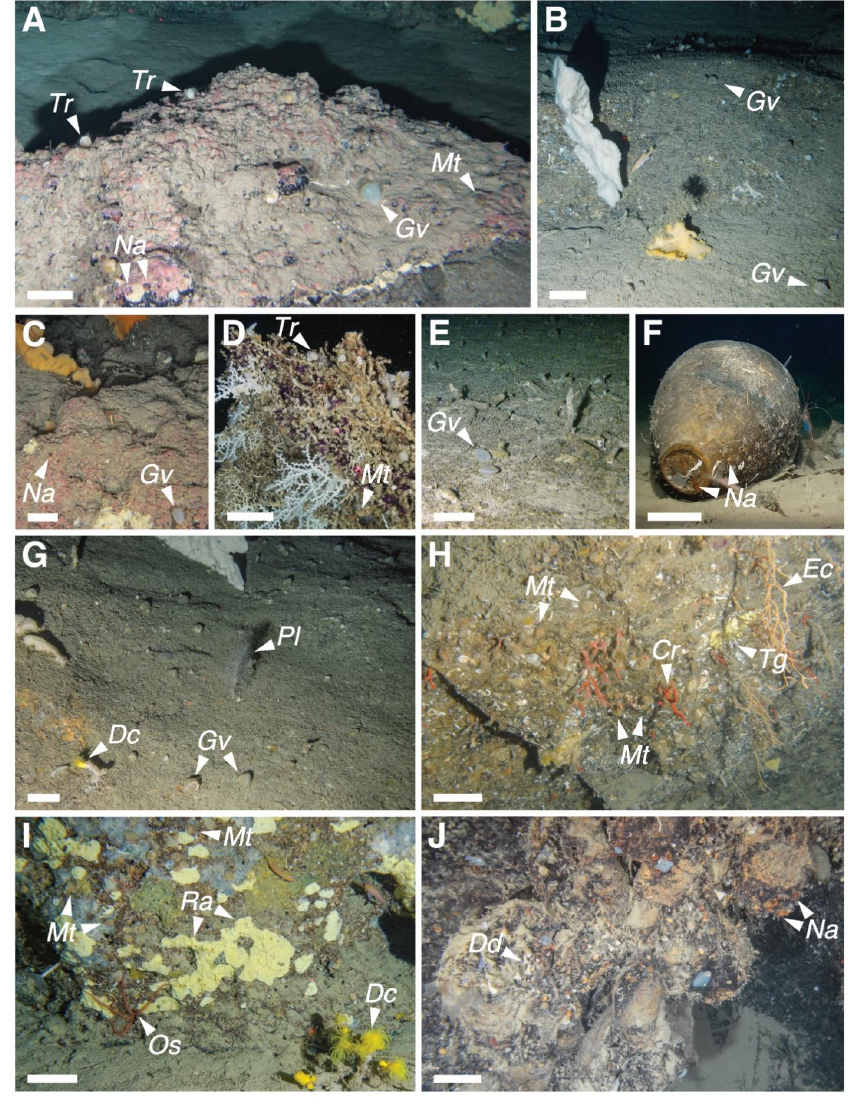
Figure 3. Ecology of the target species. ( A ) The four species together on a CCA-encrusted rock in the Pontine Archipelago (central Tyrrhenian Sea, 160 m); ( B ) specimens of G. vitreus (Gv) on a rocky boulder and on the surrounding soft bottom. Well visible the massive sponges Pachastrella monilifera and Poecillastra compressa (Vedove Shoal, western Ligurian Sea, 195 m); ( C ) sloping rock with CCA hosting G. vitreus and N. anomala (Na), together with P. compressa (Pontine Archipelago, central Tyrrhenian Sea, 160 m); ( D ) T. retusa (Tr) and M. truncata (Mt) settled on a Madrepora oculata bioconstruction, very close to the living portions of the reef (Tavolara Canyon, North-eastern Sardinia, 185 m); ( E ) individuals of G. vitreus on an horizonthal plain with skeletons of Dendrophyllia cornigera (Dc) on Vercelli seamount (central Tyrrhenian Sea, 160 m); ( F ) N. anomala on the vertical sides of an ancient terracotta amphora. On the right, an individual of Plesionika narval walking on the manufact (North Tyrrhenian Sea, 425 m); ( G ) the sloping rocky terraces of Vedove Shoal host numerous G. vitreus specimens and the frequently associated structuring species D. cornigera and Parantipathes larix (Pl) (western Ligurian Sea, 195 m); ( H ) aggregation of M. truncata and the anthozoans Thalamophyllia gasti (Tg), Corallium rubrum (Cr), and Eunicella cavolini (Ec) on a vertical rocky cliff (Ischia Island, southern Tyrrhenian Sea, 115 m); ( I ) Rhabderemia sp. (Ra), D. cornigera and Ophiacantha setosa (Os) live in close proximity to a small group of M. truncata (Pontine Archipelago, central Tyrrhenian Sea, 140 m); ( J ) peculiar association between N. anomala and the fossil valves of Neopycnodonte zibrowii in Sestri Levante (Ligurian Sea, 480 m). Scale bar: 10